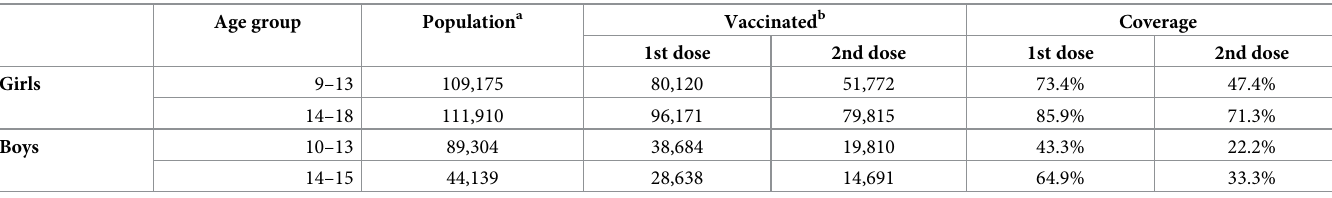
Table 1. Estimated vaccination coverage for Manaus—Amazonas—Brazil,